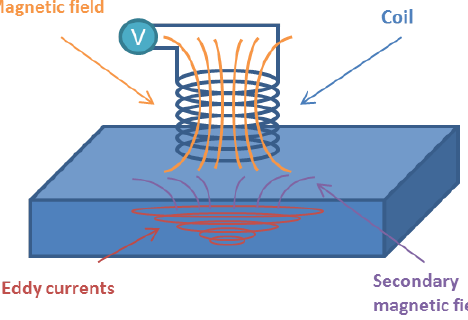
Figure 8. ECT schematic